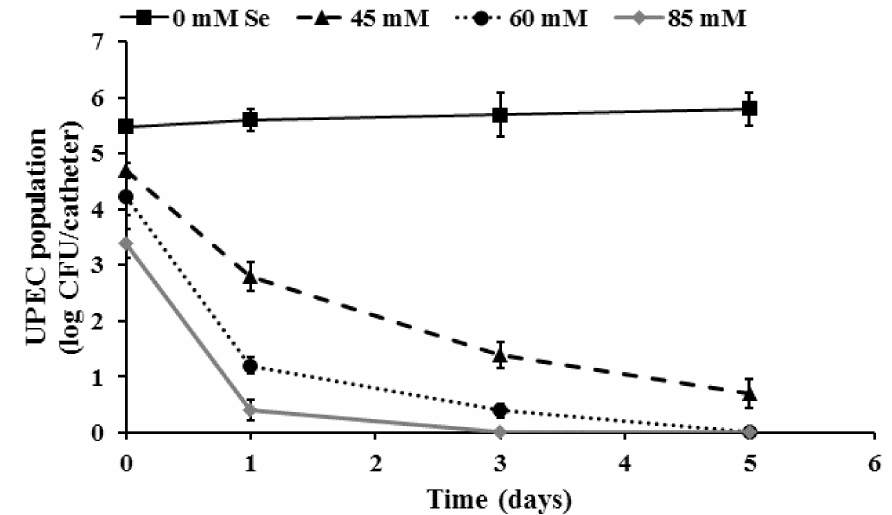
Figure 4. Inactivation of UPEC biofilm on urinary catheters by selenium. Catheter pieces (3 cm) were inoculated with UPEC (~6.0 log CFU) and incubated at 37 ◦ C for biofilm formation. The established biofilm was treated with 0, 45, 60, and 85 mM of selenium for an exposure time of 0, 1, 3, and 5 days. Following exposure, the surviving cells in the biofilm were dispersed by sonication and enumerated. Data are represented as mean ± SEM. Treatments are significantly different from the control at p ≤